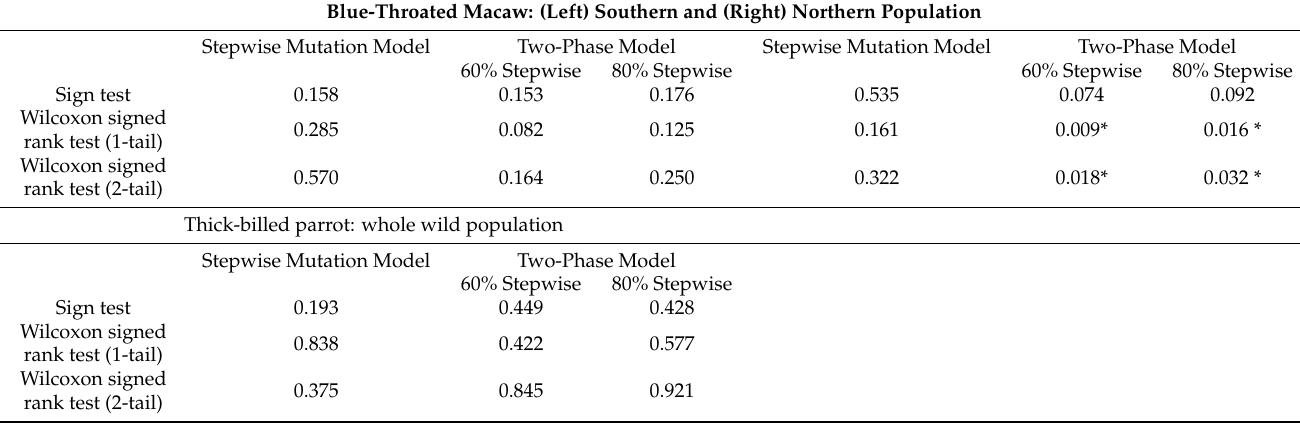
Table 3. Heterozygote excess test results indicating p -values for the blue-throated macaw and thick-billed parrot * = p -value <